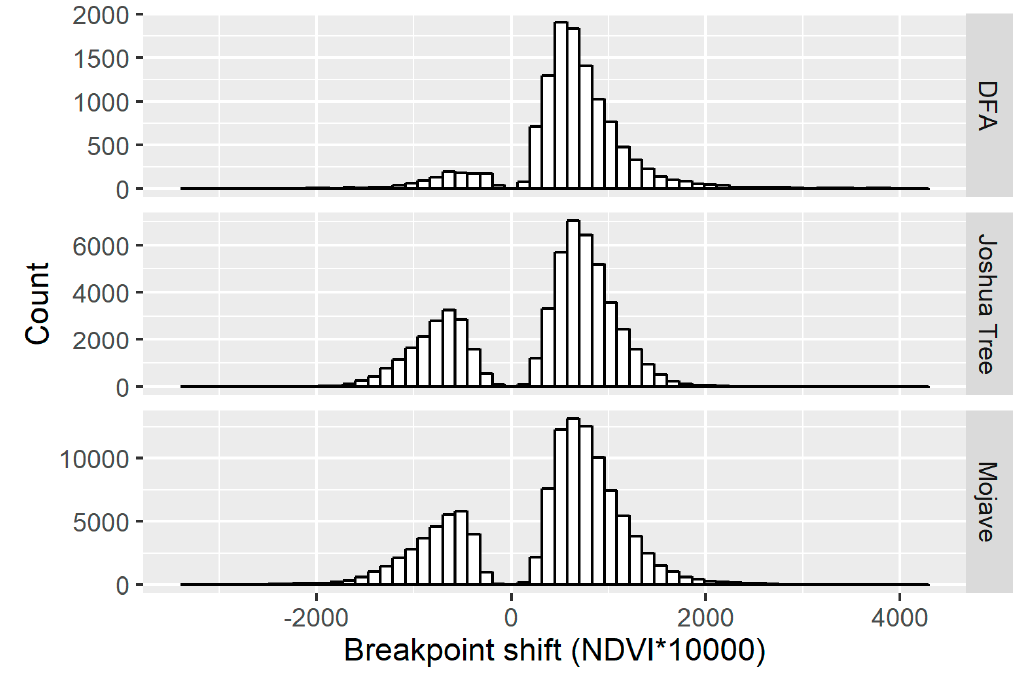
Figure 9. Histograms of breakpoint shifts by site.